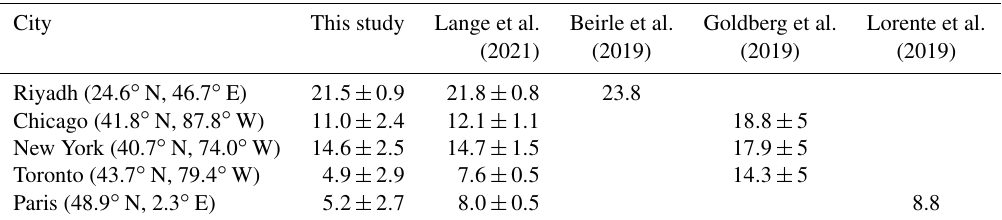
Table 8. NO x emission estimates in large urban areas obtained from this study and previous studies. The unit is megagrams (Mg) per hour. Emissions are averaged for the period 15 April–31 May 2018 for this study, March 2018–November 2020 for Lange et al. (2021), December 2017–October 2018 for Beirle et al. (2019), May–September 2018 for Goldberg et al. (2019), and February–June 2018 for Lorente et al. (2019). The ranges of the emissions are emission analysis spreads in this study, while the ranges are the errors estimated by individual previous studies.